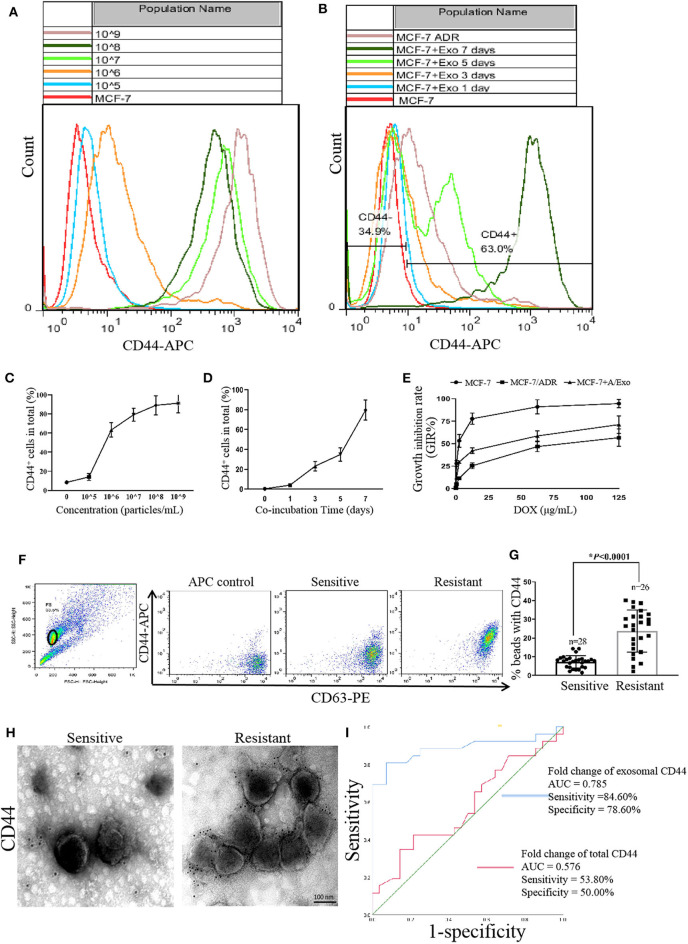
CD44 was transmitted from MCF-7/ADR to MCF-7 cells via exosomes. (A,C) A/Exo coincubation increased the percentage of CD44 in MCF-7 cells in a concentration-dependent manner. The expression of CD44 in MCF-7+A/Exo with 1 × 105, 1 × 106, 1 × 107, 1 × 108, and 1 × 109 particles/mL was 5.73 ± 0.10%, 14.10 ± 0.70%, 63.00 ± 5.60%, 88.12 ± 9.70%, and 92.0 ± 11.20% respectively. There were no significant differences between the 1 × 108 and 1 × 109 group (p > 0.05). (B,D) A/Exo coincubation increased the percentage of CD44 in MCF-7 cells in a time-dependent manner. The expression of CD44 in MCF-7+A/Exo at days 0, 1, 3, 5, and 7 was 4.35 ± 0.71%, 11.42 ± 1.60%, 33.21 ± 4.70%, 58.90 ± 6.54%, and 91.10 ± 9.66% respectively. After 7 days of incubation, the expression of CD44 in MCF-7+A/Exo reached 91.10 ± 9.66%, while the expression of CD44 in MCF-7/ADR was only 77.30 ± 10.12%. (E) The DOX sensitivity of MCF-7 was significantly decreased after 7 days of incubation with 1 × 108 particles/mL of A/Exo. (F) Exosomes derived from peripheral donor blood were pulled down on beads, stained with anti-CD63-PE and anti-CD44-APC, and analyzed by flow cytometry. (G) Quantitative analysis of flow cytometry results showed that the exosomal CD44 in the serum of nonresponders was significantly higher than that in chemotherapy-responsive group (p < 0.0001). “n” stands for the number of patients. (H) Immunogold TEM results showed that exosomal CD44 in the nonresponders was significantly higher than that in the chemotherapy-responsive group. (I) ROC curves indicated that exosomal CD44 shows AUC = 0.785, a sensitivity of 84.60%, and a specificity of 78.60%, while serum CD44 shows an AUC of 0.576, a sensitivity of 53.80%, and a specificity of 50.00%.